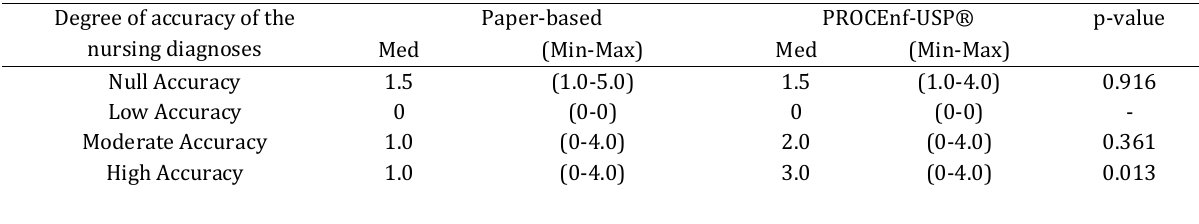
Table 1.Comparison of the degree of accuracy of the nursing diagnoses indicated by the nursing students in the PROCEnf-USP® and paper-based systems (n=17) Degree of accuracy of